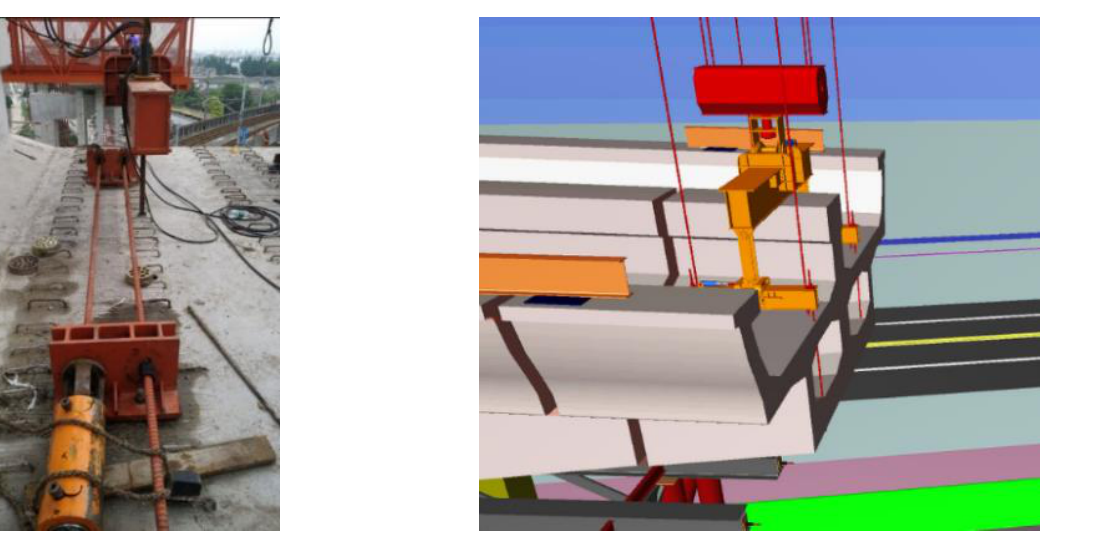
Figure 10. The temporary